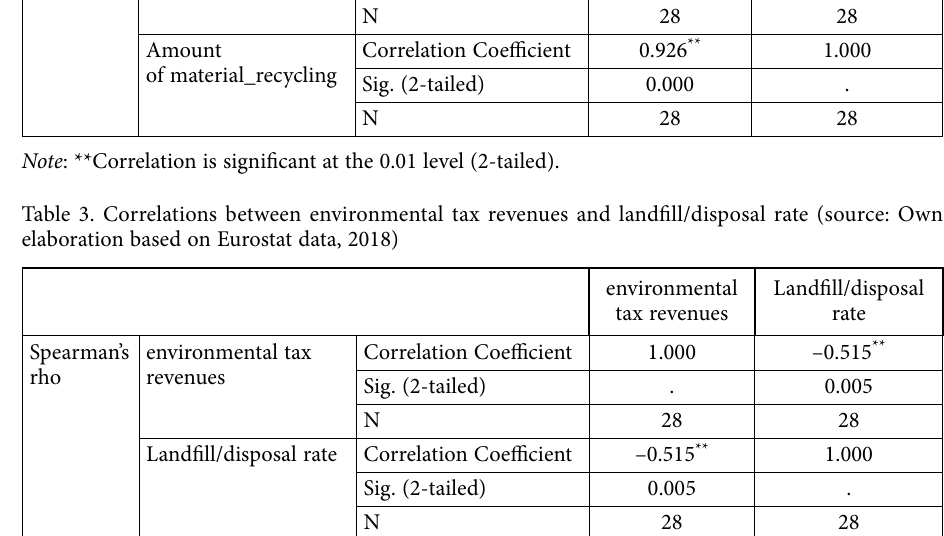
Table 2. Correlations between environmental tax revenues and the amount of material recycling (source: Own elaboration based on Eurostat data, 2018) Environmental Amount of tax revenues material_recycling Spearman’s Environmental Correlation Coefficient 1.000 0.926 ** rho tax revenues Sig. (2-tailed) . 0.000 N 28 28 Amount Correlation Coefficient 0.926 ** 1.000 of material_recycling Sig. (2-tailed) 0.000 . N 28 28